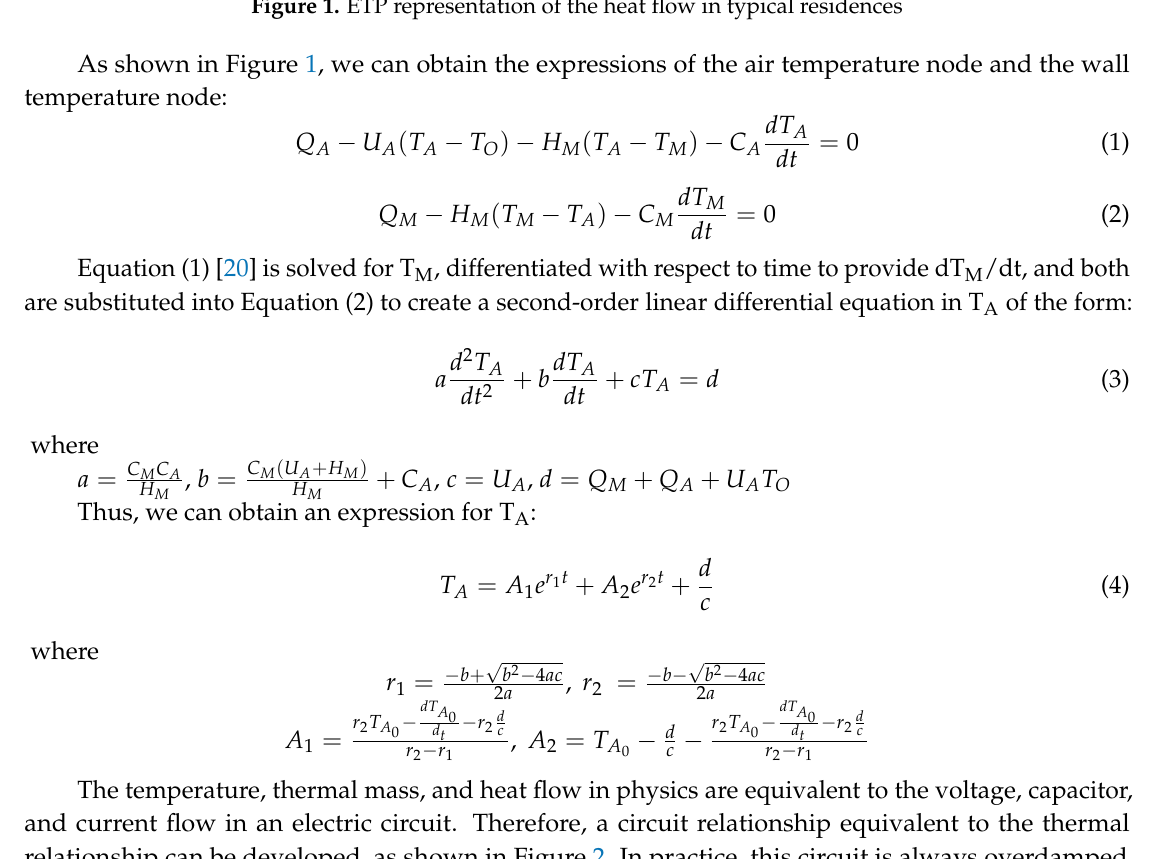
Figure 1. ETP representation of the heat flow in typical residences